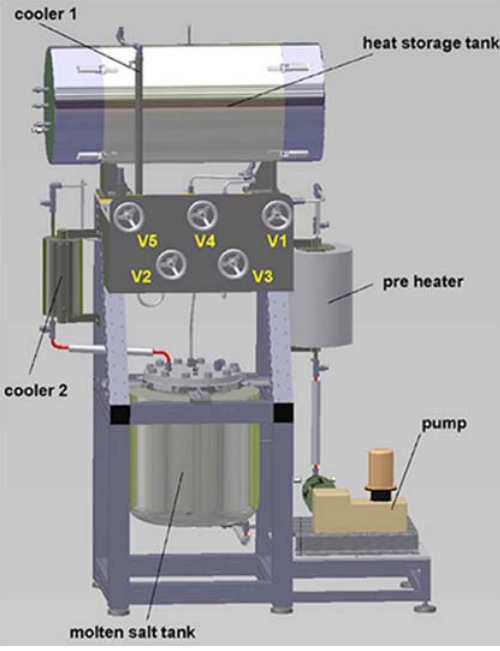
Figure 5. Heat storage demonstration unit on the basis of Mg 2 FeH 6 . Reproduced with permission from [63], Copyright Elsevier, 2017.